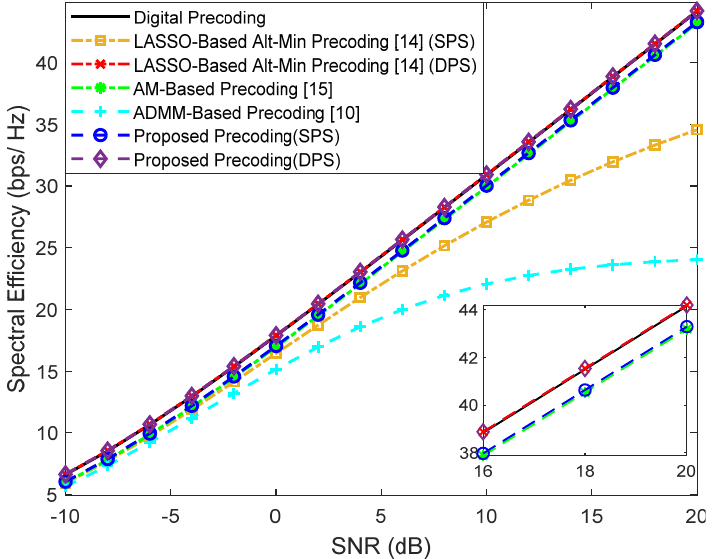
Figure 4. Spectral efficiency versus SNR achieved by different methods with = 4